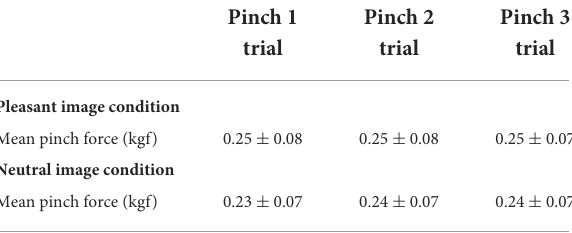
TABLE 1 Mean pinch force values in the pleasant and neutral image conditions.